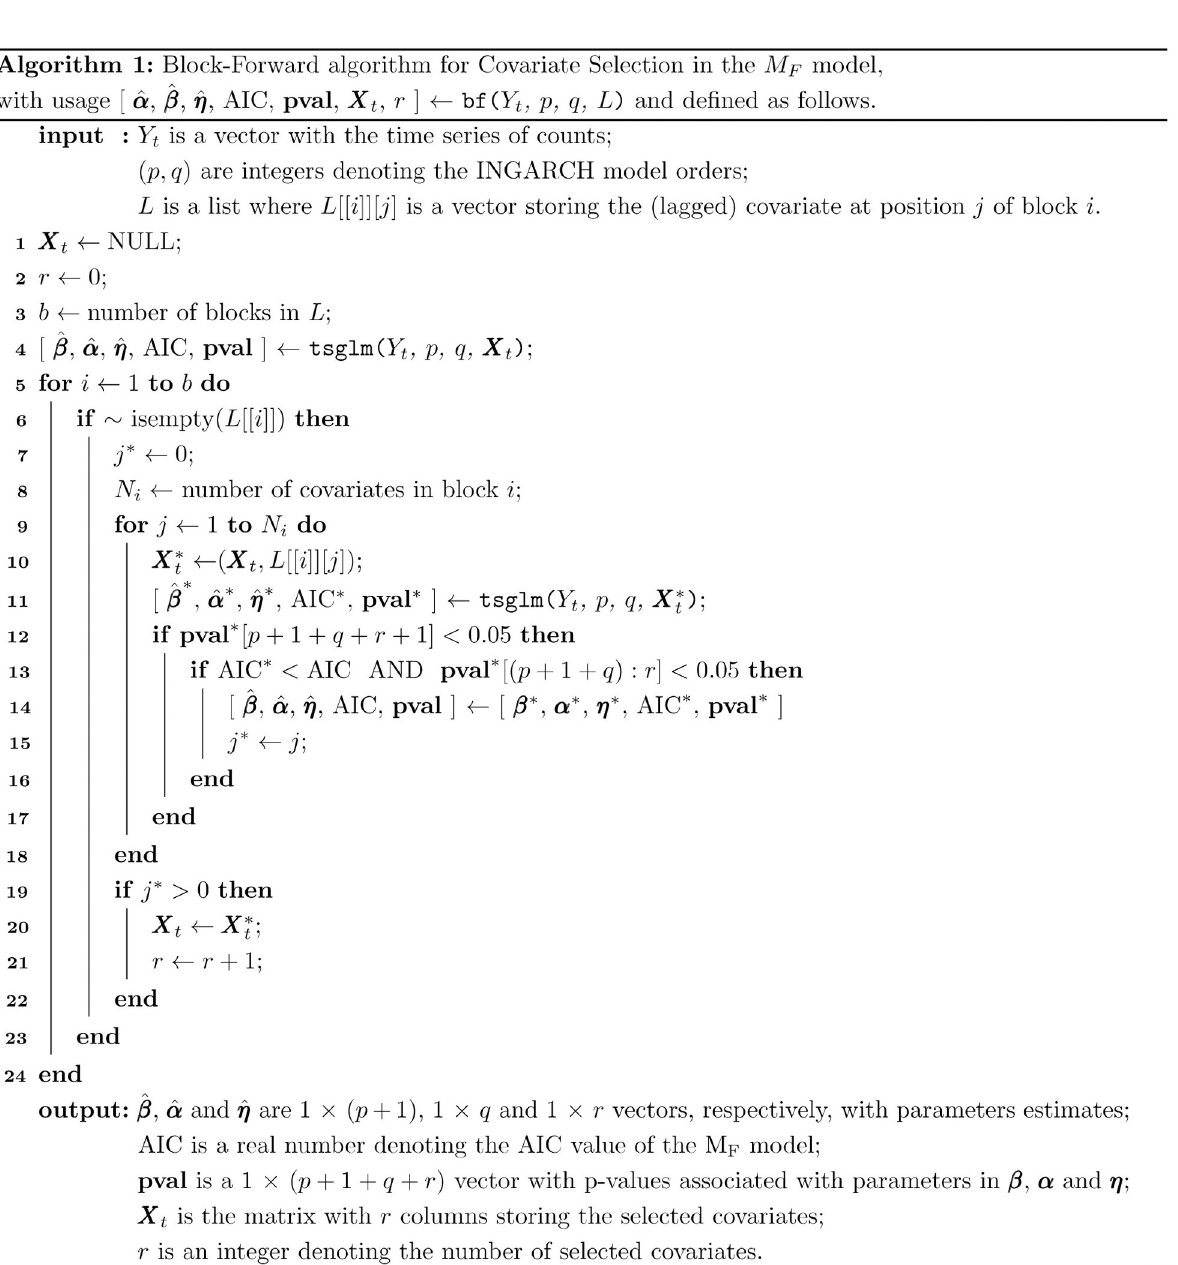
Fig 4. Algorithm outline for the block-forward